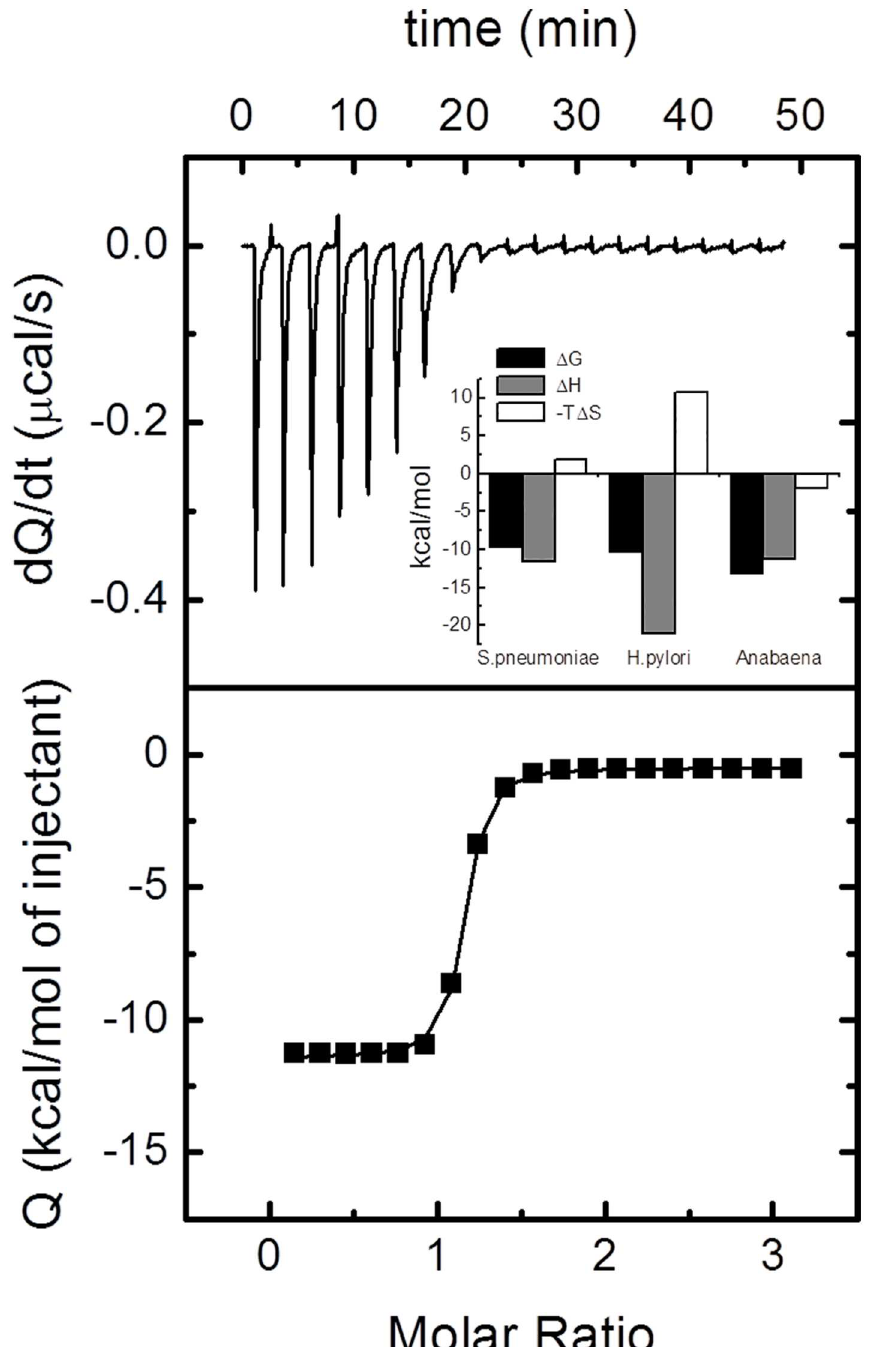
Fig 5. Titration of 20 μ M Apo Sp Fld with 300 μ M FMN at 25˚C in 150 mM NaCl, 100 mM MES, pH 6.5. The upper panel shows the thermogram (thermal power as function of time) and the lower panel shows the bindingisotherm (normalizedheat as a function of the molar ratio). The continuousline is the non-linear fitting curve obtained using a model consideringa single ligand bindingsite. The inset in the upper panel shows a comparison of the thermodynamic bindingprofiles obtained by ITC for FMN interacting with apoflavodoxins from S . pneumoniae , Helicobacter pylori , and Anabaena PCC7119: Δ G (black bars) Δ H (gray bars) -T Δ S (white bars). Data for the H . pylori and Anabaena complexes come from reference